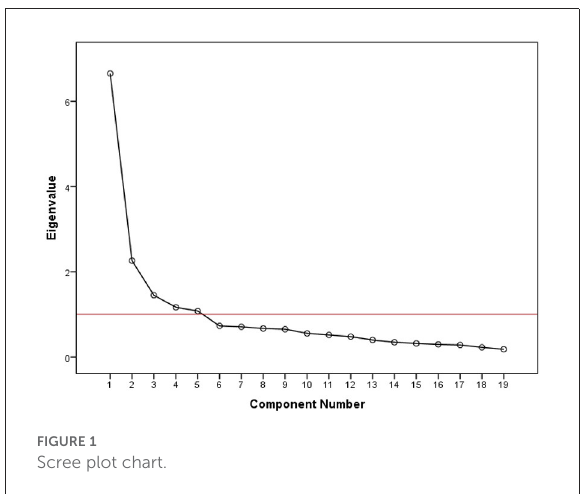
FIGURE1 Scree plot chart.